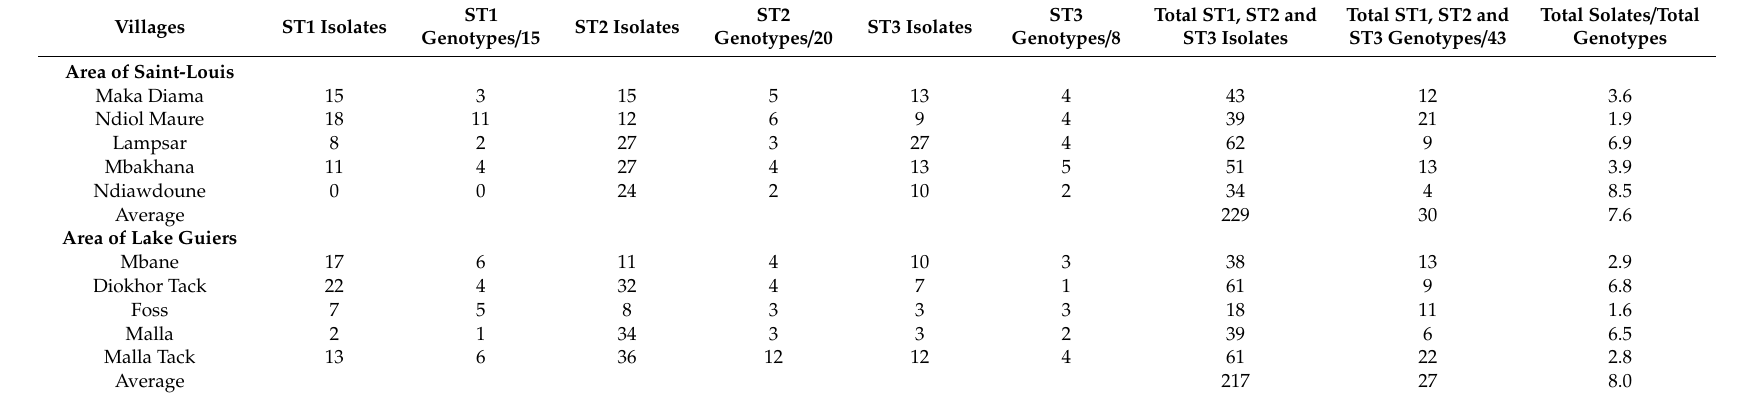
Table 3. Distribution of ST1, ST2, and ST3 genotypes of Blastocystis sp. in the 10 Senegalese